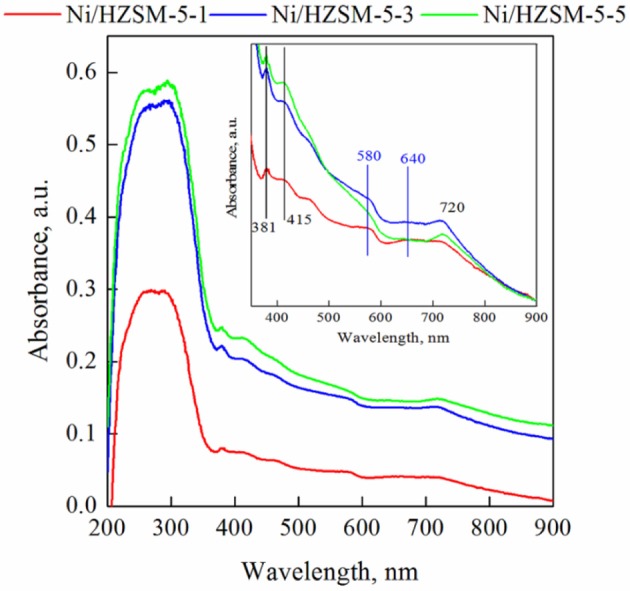
UV-Vis DR spectra of Ni/HZSM-5 catalysts. Inset shows magnification of the range between 350 and 900 nm. The spectra were offset vertically to match intensity at 900 nm for easier comparison.